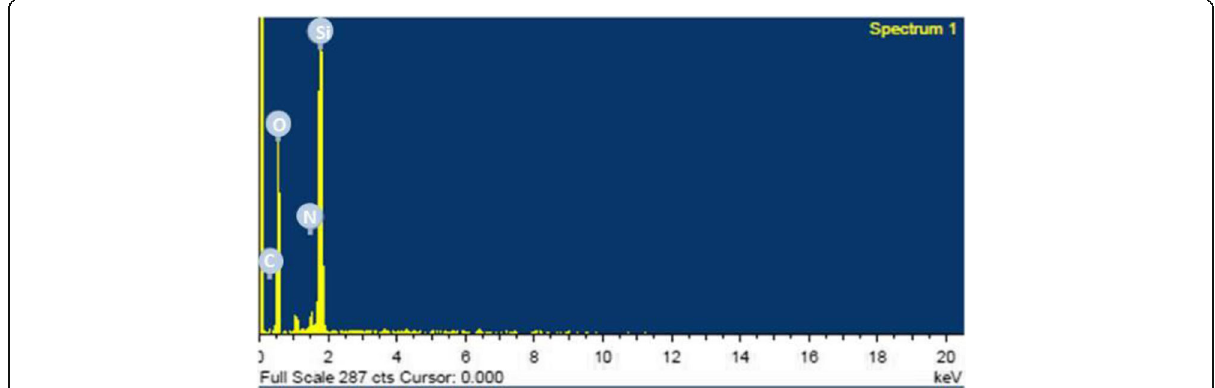
Fig. 4 EDX image of Pani@SG (ES)-S 2 nanocomposite